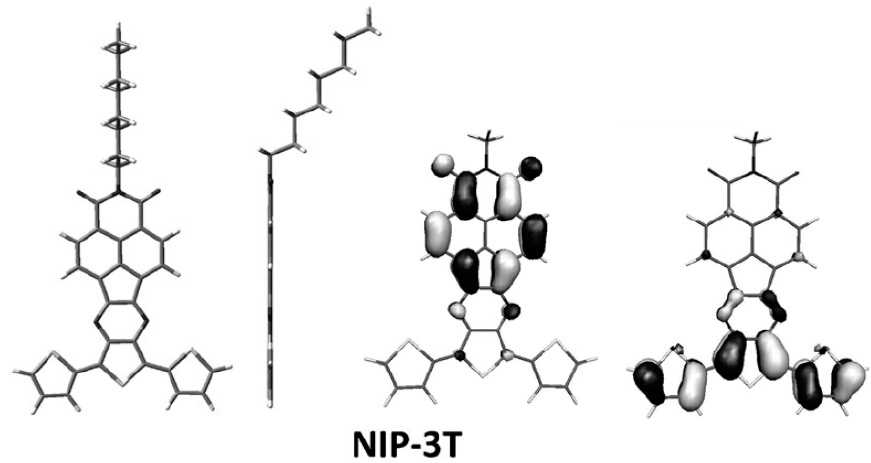
Figure 13. DFT//B3LYP/6-31G** geometry optimization (left), LUMO (center) and HOMO (right) of NIP-3T . Adapted with permission from Chem. Eur. J . 2013 , 19 , 12458–12467. Copyright© 2013 WILEY-VCH Verlag GmbH & Co. KGaA, Weinheim, Germany [29].